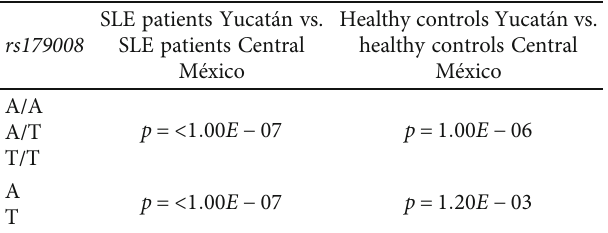
Table 3: Comparison of allelic and genotypic frequencies of the rs179008 between SLE patients and healthy controls from Yucatán and Central México. SLE patients Yucatán